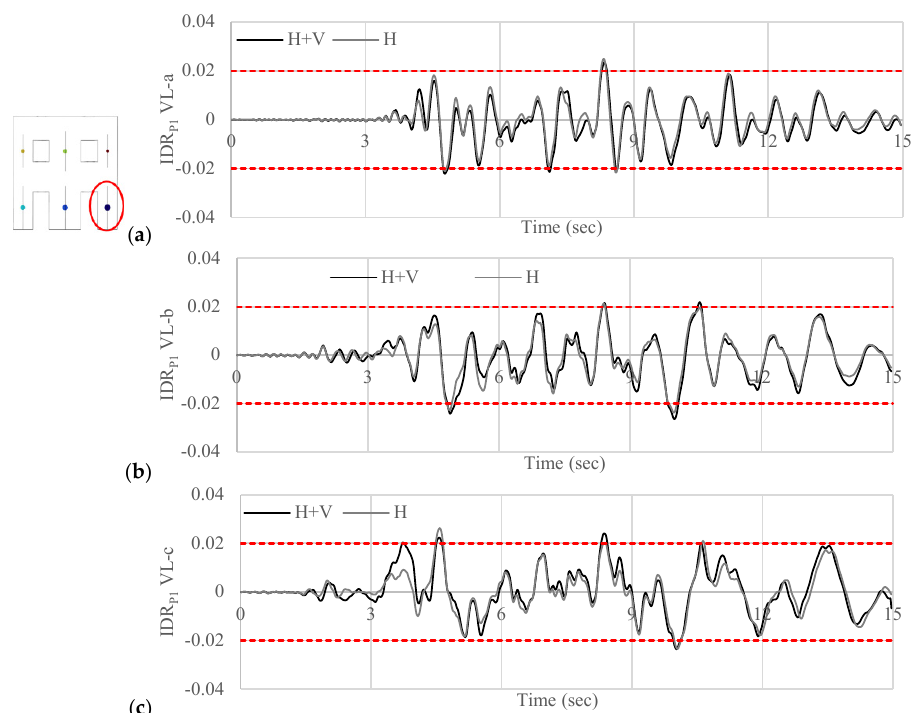
Figure 12. IDRs obtained subjecting the structure with VL-a ( a ), VL-b ( b ), and VL-c ( c ) to earthquake #1. The red lines indicate the IDR limit of 2%.